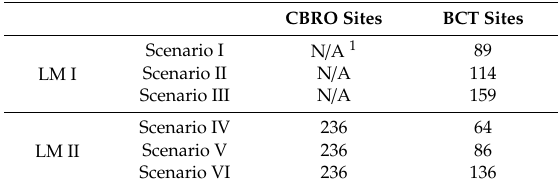
Table 2. The number of centralized biomass recovery operation (CBRO) and biomass conversion technology (BCT) sites for each scenario within logistics models (LM) I and II, respectively. CBRO Sites BCT Sites Scenario I N / A 1 89 Scenario II N / A LM I N / A 159 Scenario IV 236 64 Scenario V 236 86 LM II Scenario VI 236 136